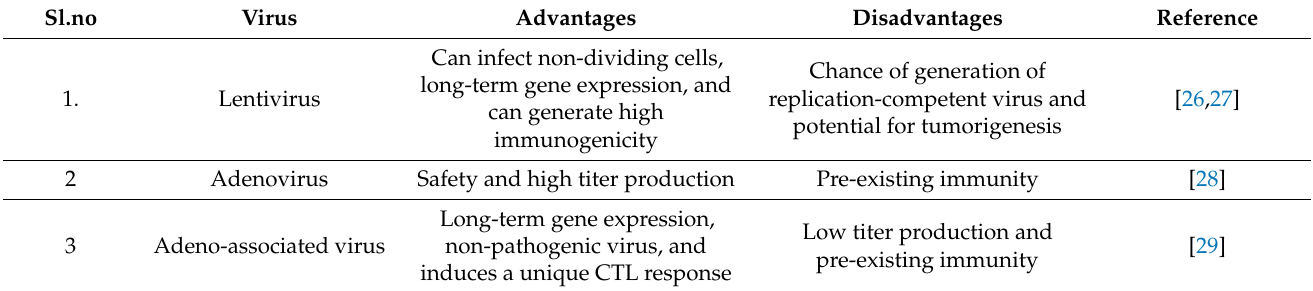
Table 1. Advantages and disadvantages of major viral vectors for DNA vaccine delivery. Sl.no Virus